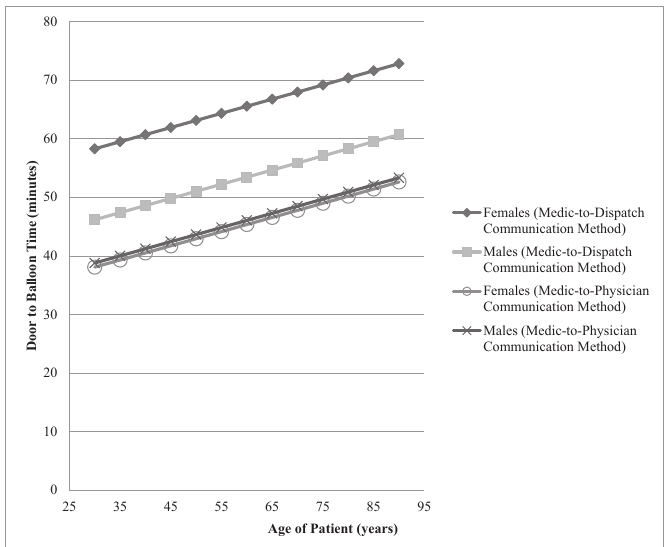
Figure 4. Logistic regression to predict door-to balloon time vs. age by sex and notification